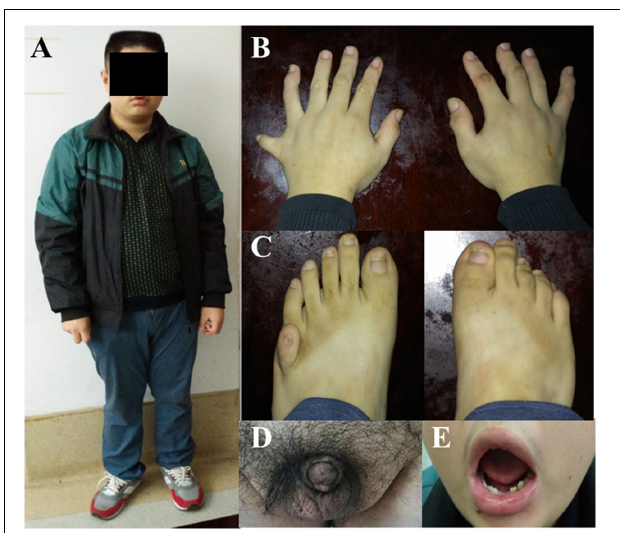
FIGURE 1 | Systemic manifestations of BBS patients. The Wechsler Intelligence Score showed that this patient (F1-II:1) only had an 6-year-old intellectual level, his physical signs are: (A) Obesity (BMI 33.2 Kg/m 2 ). (B) Polydactyly of the right hand and left foot. (C) Sexual organ dysplasia. (D) Dental dysplasia. (E) Abnormal tooth